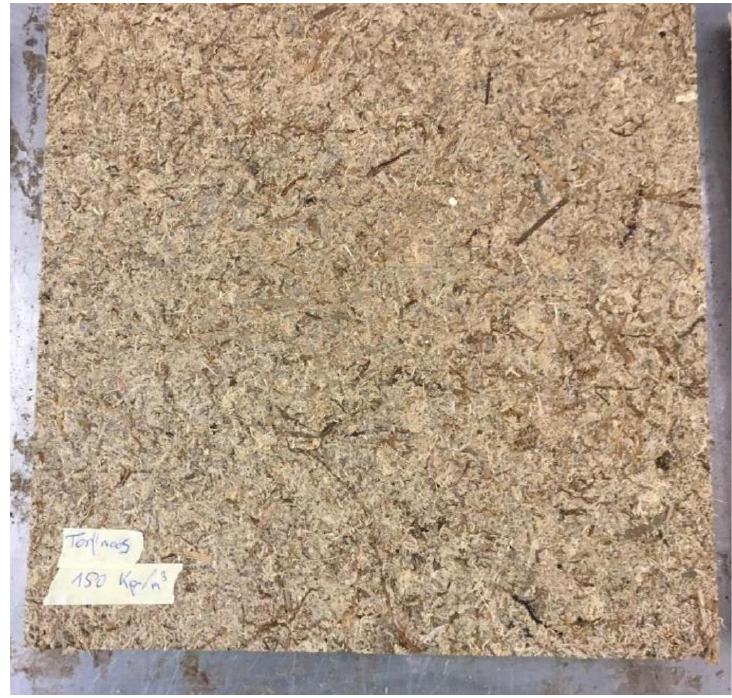
Figure 2. Peat moss panel (resin-bound) with a density of 150 kg/m³.